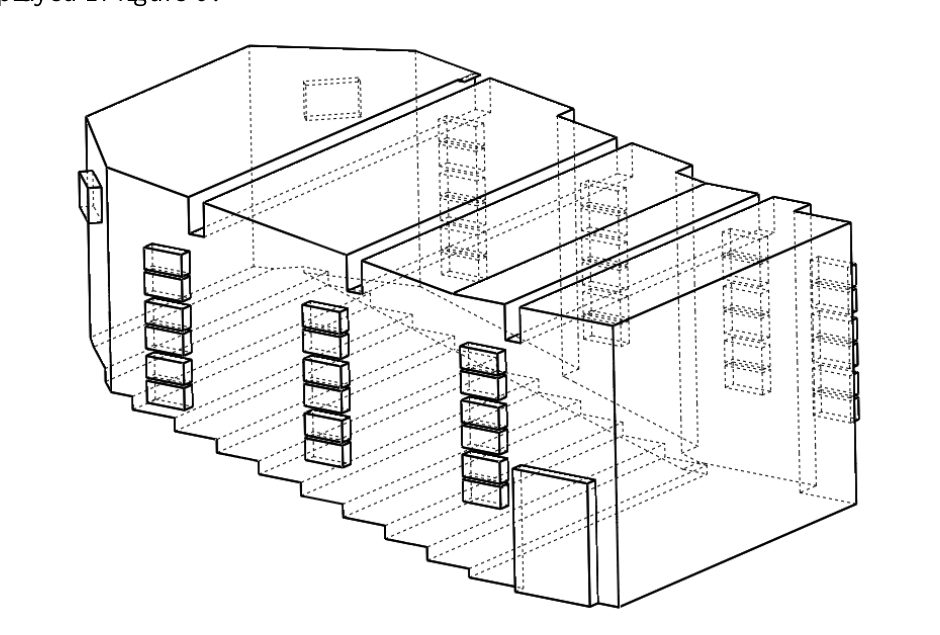
Figure 6. Lecture theatre fluid domain